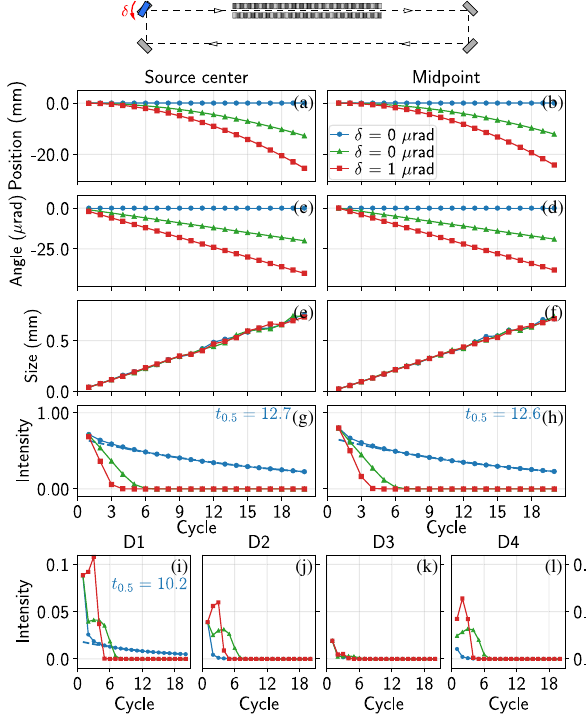
FIG. 10. Similar to Fig. 9, but with yaw angle error δ in crystal C 4 .